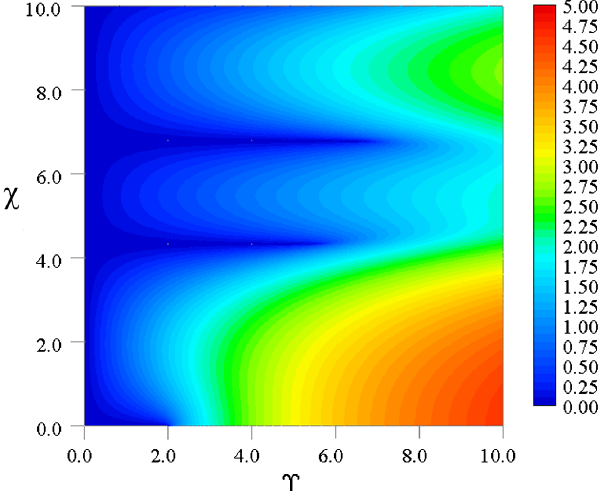
FIG. 3. Flat contour plot for the growth factor g × T function of ϒ and χ for positive χ .